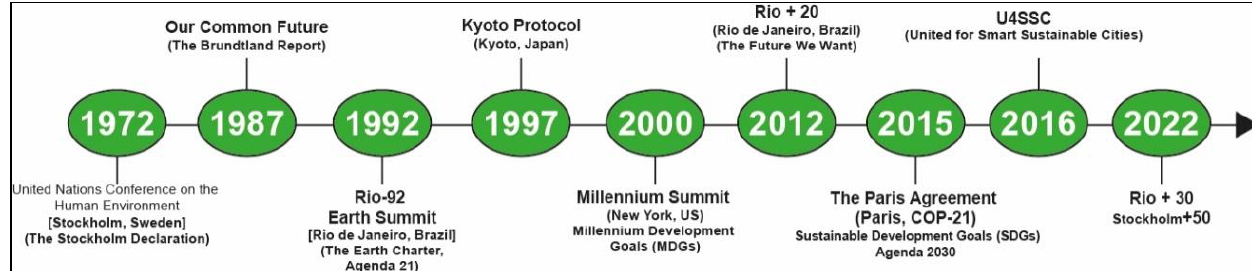
Figure 1. World population (past–present–future projections) Source: [4]. Adapted by the author.